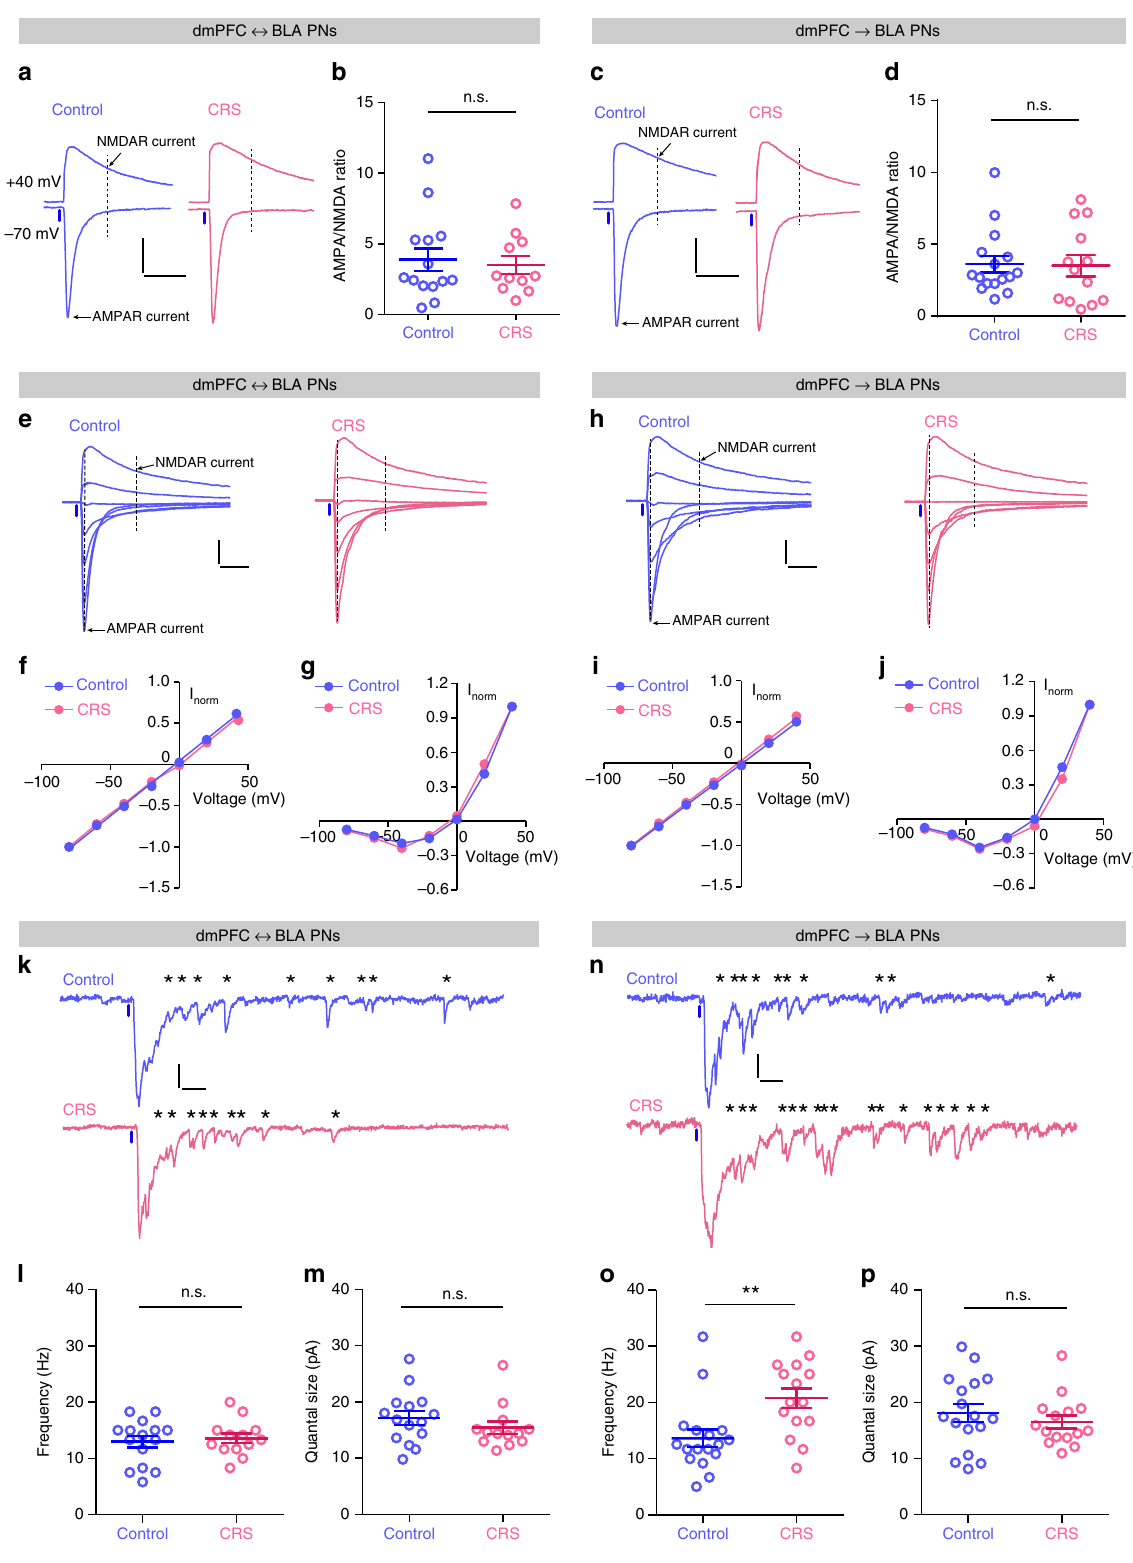
during OFT and the effect persisted for at least 24 h post-LS (Fig. 7f), suggesting lasting in fl uence of LS. By contrast, 3-min LS failed to affect the mice ’ s behavior in EPM and OFT (Fig. 7g – j). Both 3- and 10-min LS did not alter the distance mice traveled in OFT and their movement speed (Supplementary Fig. 8a – f). These